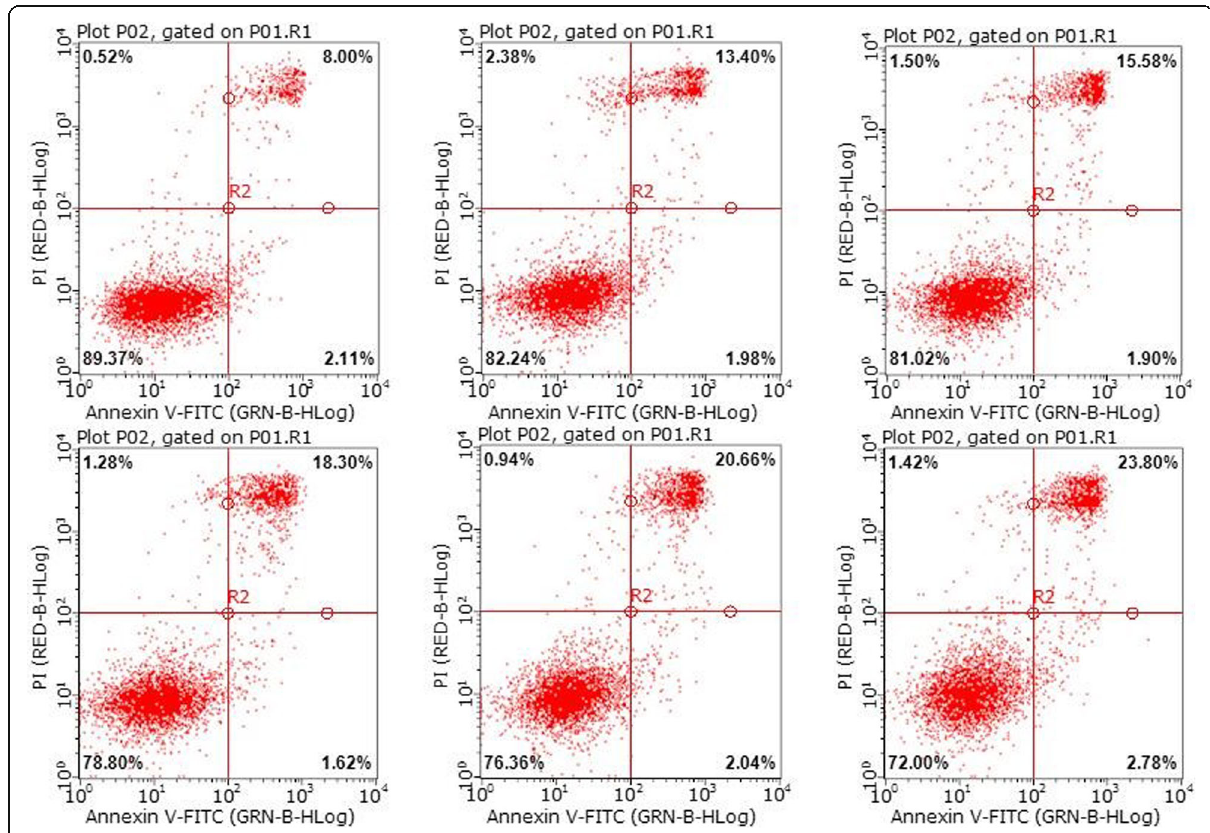
Fig. 7 Representative two-dimensional contour density plots to determine fractions of live, apoptotic, and necrotic cells, when exposed to DRN- GNPs at different concentrations (0 – 100 μ g/mL) for 24 h, respectively. Cell necrosis and apoptosis were measured by using PI